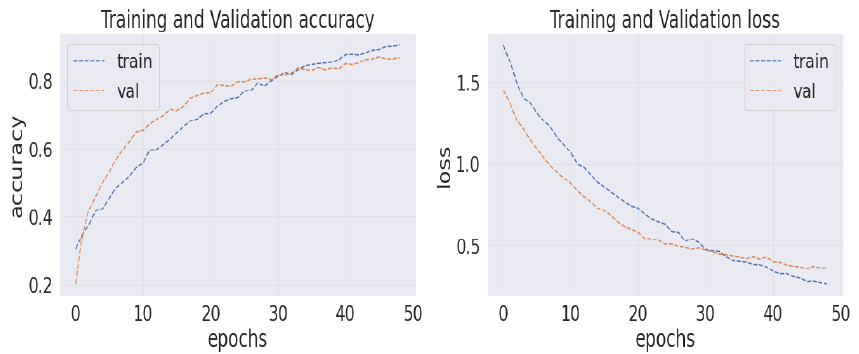
Figure 7. The left corner of the image represents the training and validation accuracy graph, and the right corner shows the training and validation loss graph.